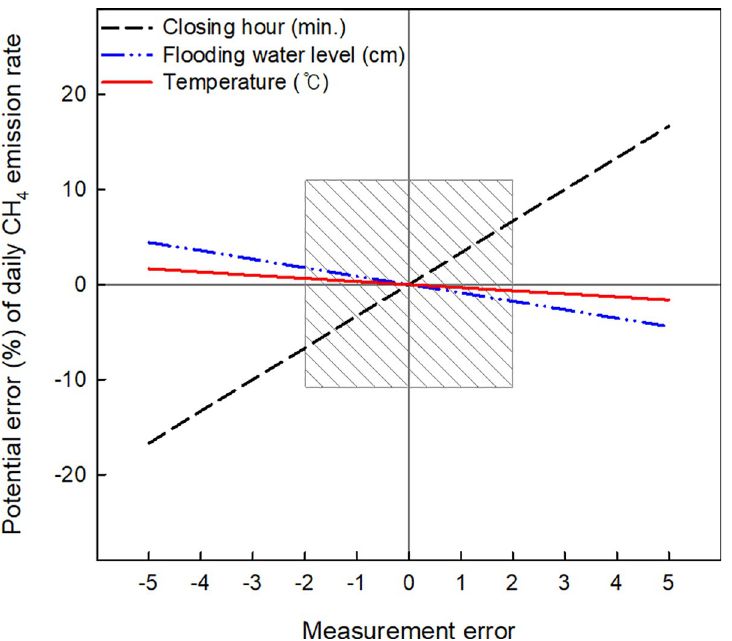
Fig 6. Potential error (%) in daily CH 4 emission rates coming from chamber management practices during gas sampling. The shaded square box indicates the range of potential error produced by the measurement error of ± 2 minutes of closing hour, ± 2 cm of flooding water level, and ± 2˚C of headspace